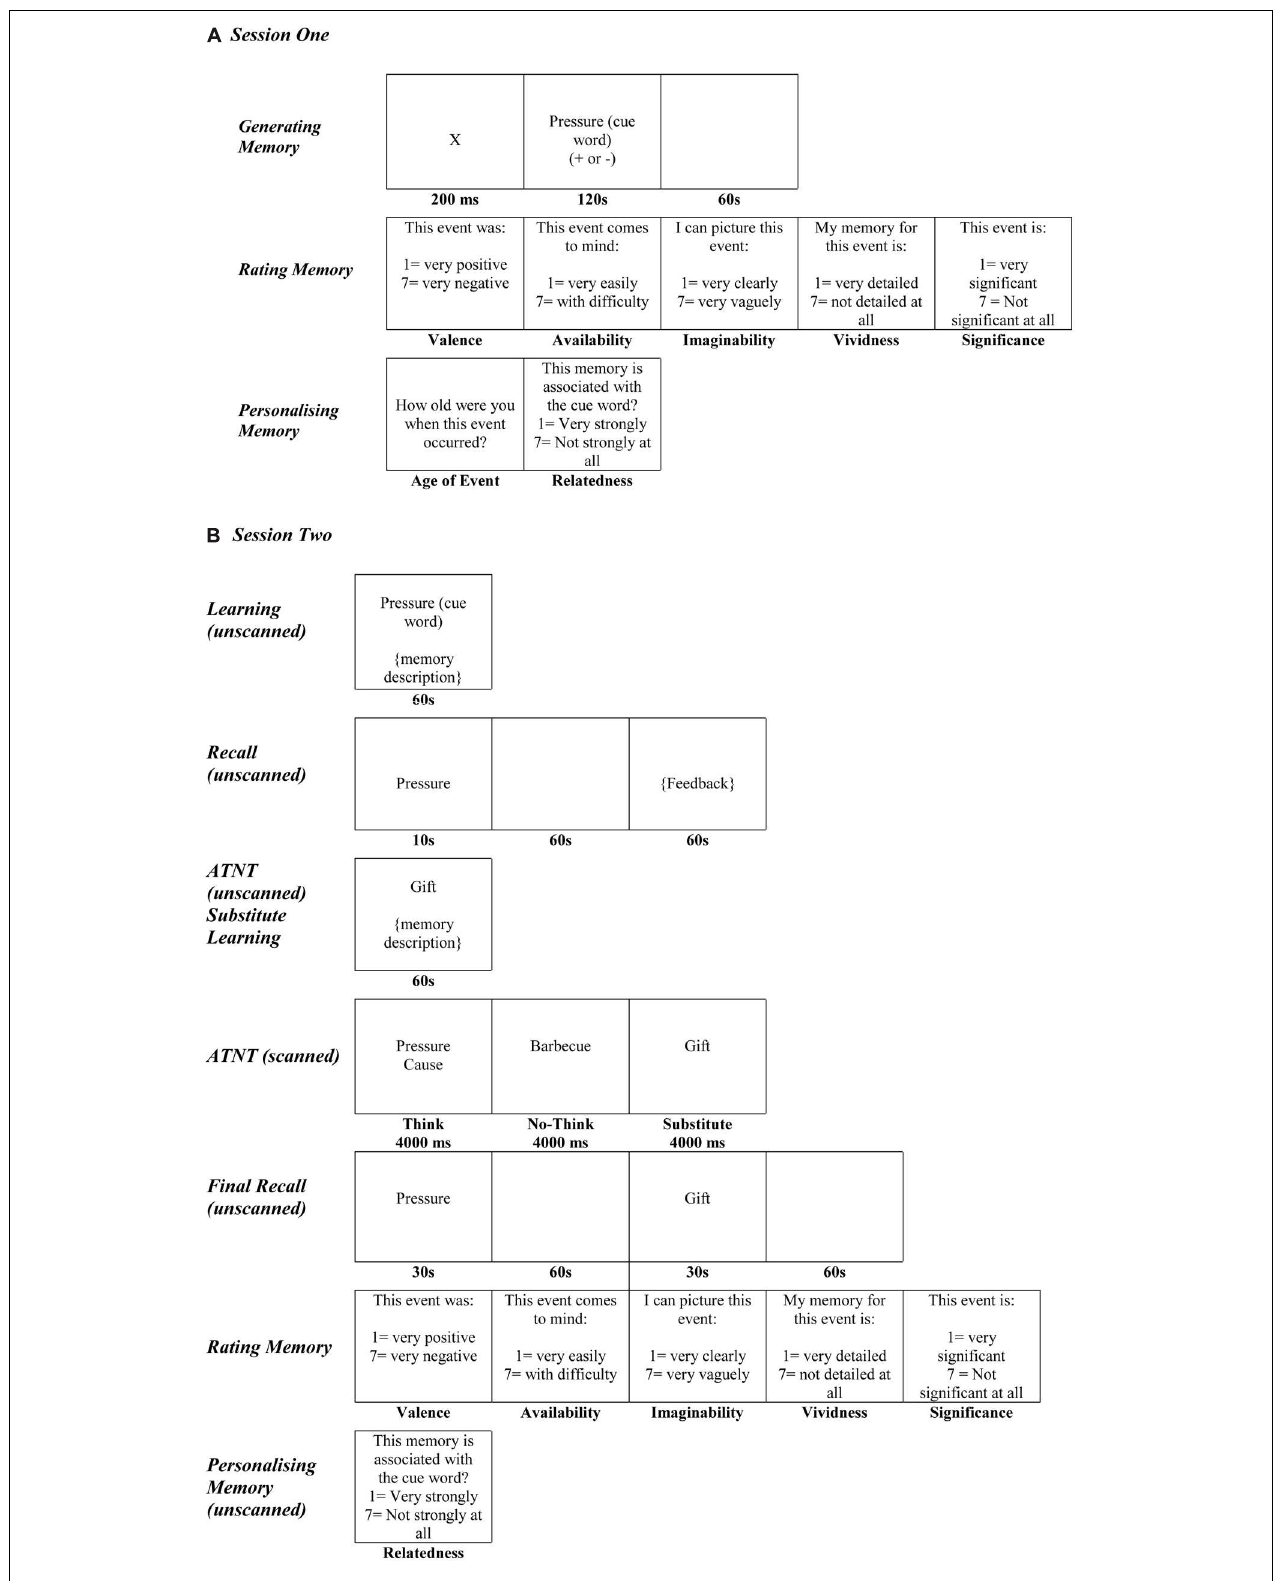
FIGURE 1 | (A) Experimental procedure for session 1. (B) Experimental procedure for the ATNT task in session 2.